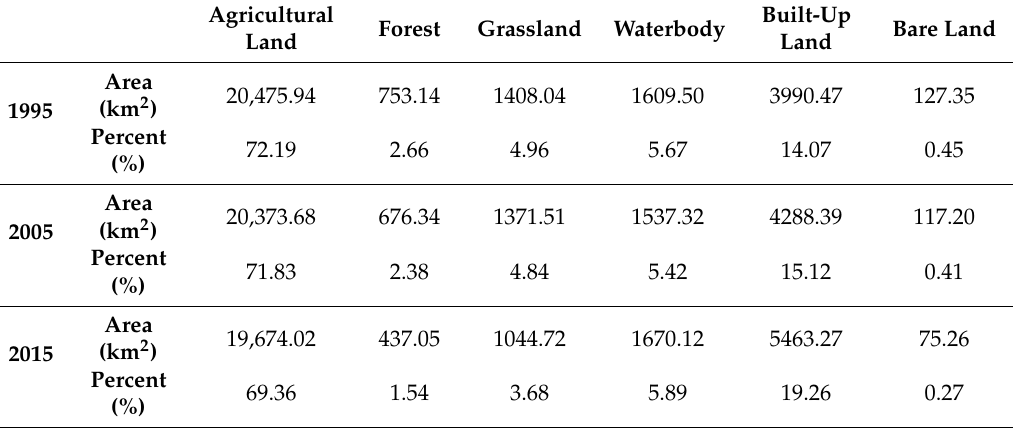
Table 4. Land use statistics in the NLB for 1995, 2005, and